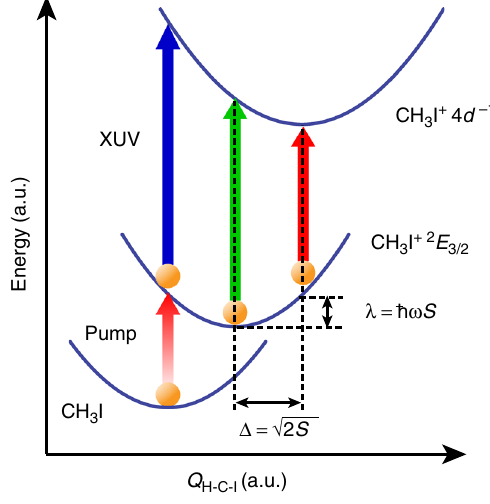
fi t to a sum of two damped cosinusoidal oscillations, i.e.,